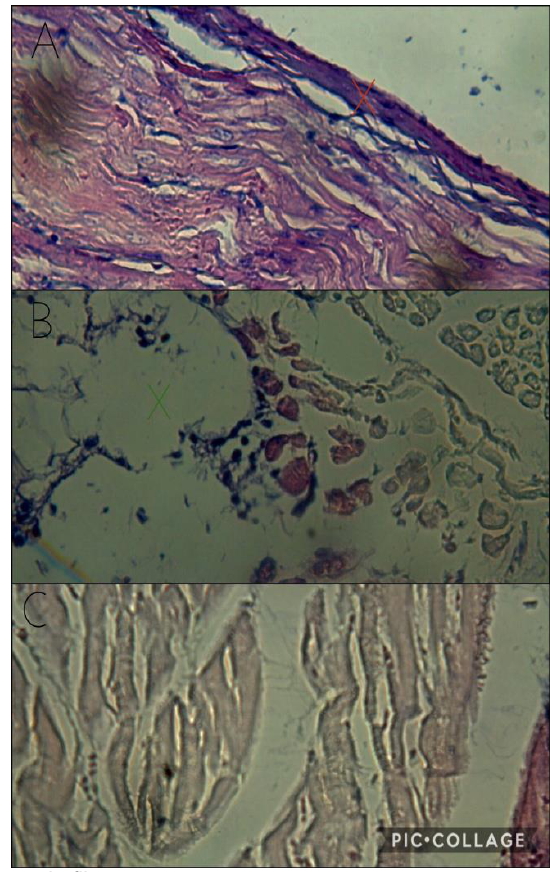
Figure 14. Proximal subepicardial section. A, showing transverse running pattern of muscle fibers near the endocardium (red x). B, showing longitudinal running pattern of muscle fibers near the epicardium (green x). C, showing mixed running pattern of muscle fibers in the center of the subepicardial layer.